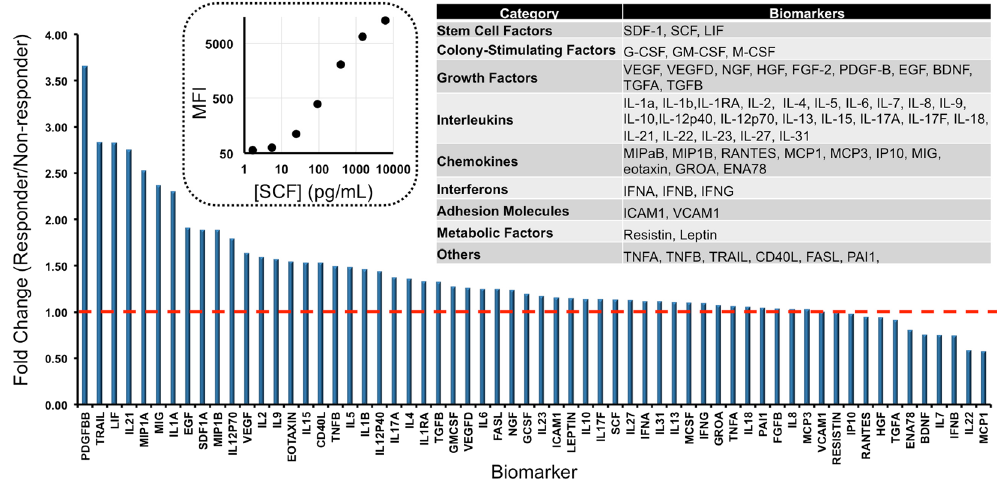
Figure 1. Biomarkers used in the study. Fold change of responders ( Δ EF > 0) versus non-responders ( Δ EF ≤ 0) is demonstrated. Dashed inset graph shows the representative calibration curve for stem cell factor. Right upper table shows the broad classes of the biomarkers used in present study. Abbreviations. BDNF: brain-derived neurotrophic factor; CXCL: chemokine; EGF: epidermal growth factor; ENA78: CXCL5; FASL: fatty acid synthase ligand; FGF2: fibroblast growth factor; G-CSF: granulocyte colony-stimulating factor; GM- CSF; granulocyte macrophage colony-stimulating factor; GROA: CXCL1; HGF: human growth factor; ICAM: